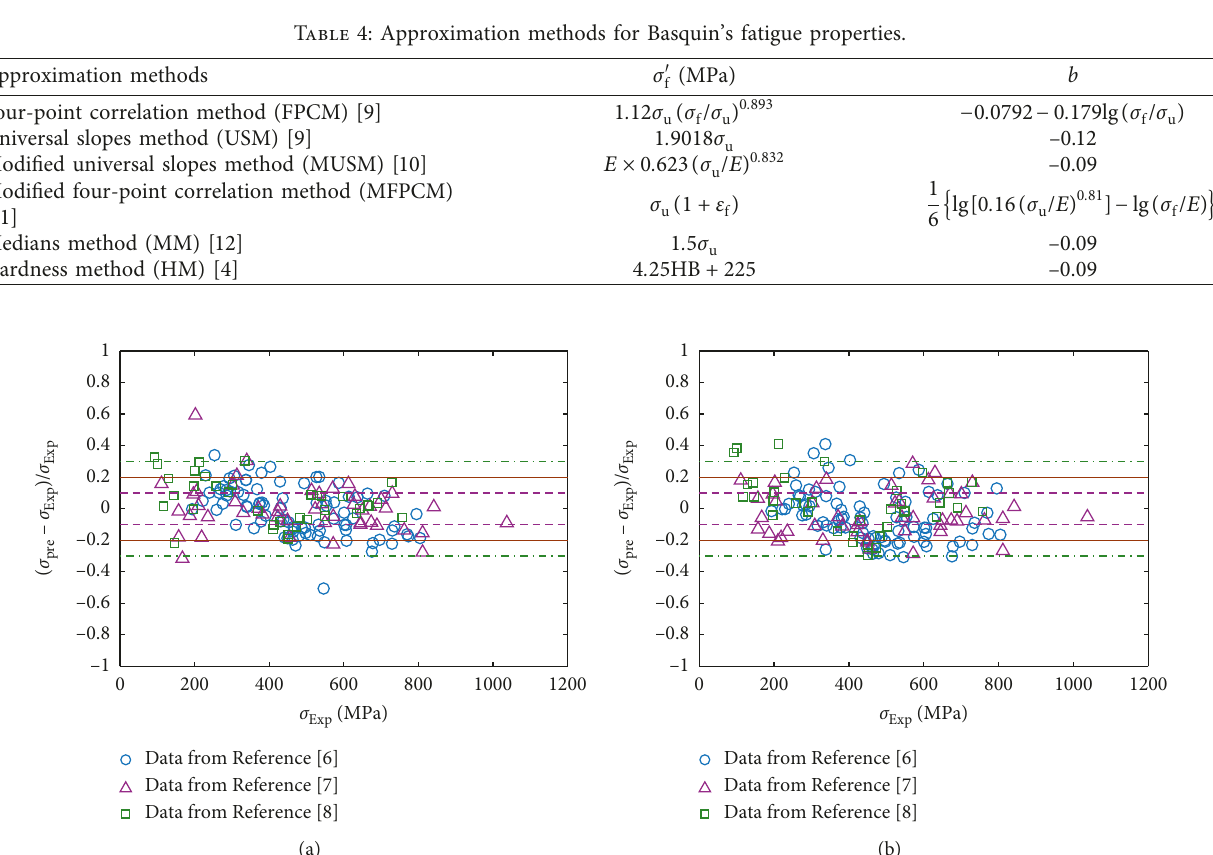
Figure 3: Comparison of the direct methods using the tested data from [6–8]: (a) HB-based and (b) σ